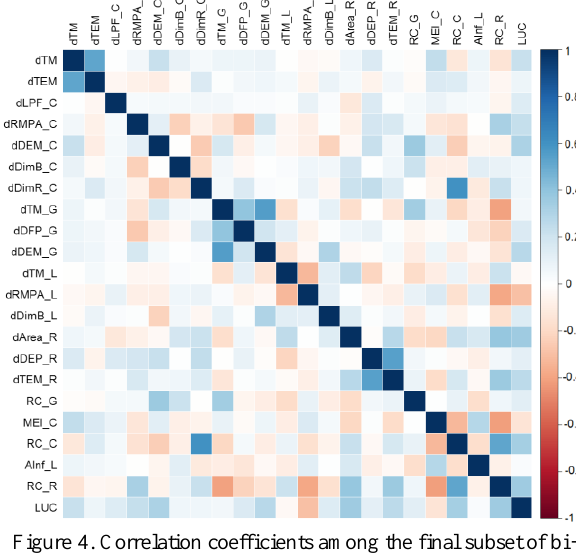
Figure 4. Correlation coefficients among the final subset of bi- temporal metrics after PCA selection, where the sub-index refers to each land use: commercial (C), green areas (G), leisure (L), and residential (R), and its absence means FUA level. Label names are as in Table 1. Metrics with prefix “d” correspond to FIC, and the rest to